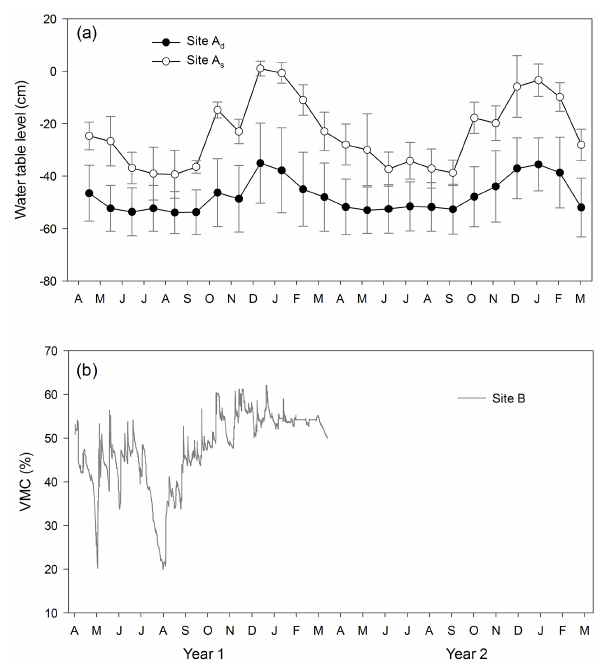
Figure 3. (a) Mean monthly water table levels (cm) at Site A d and A s (error bars are standard deviation of the monthly means) and (b) Volumetric Moisture Content (% VMC) at Site B (in the surface 5cm of the peat).